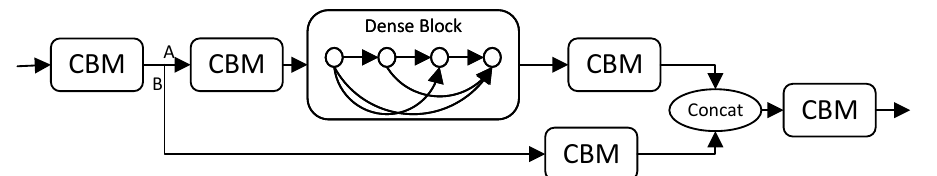
Figure 3. The CSPDenseNet structure